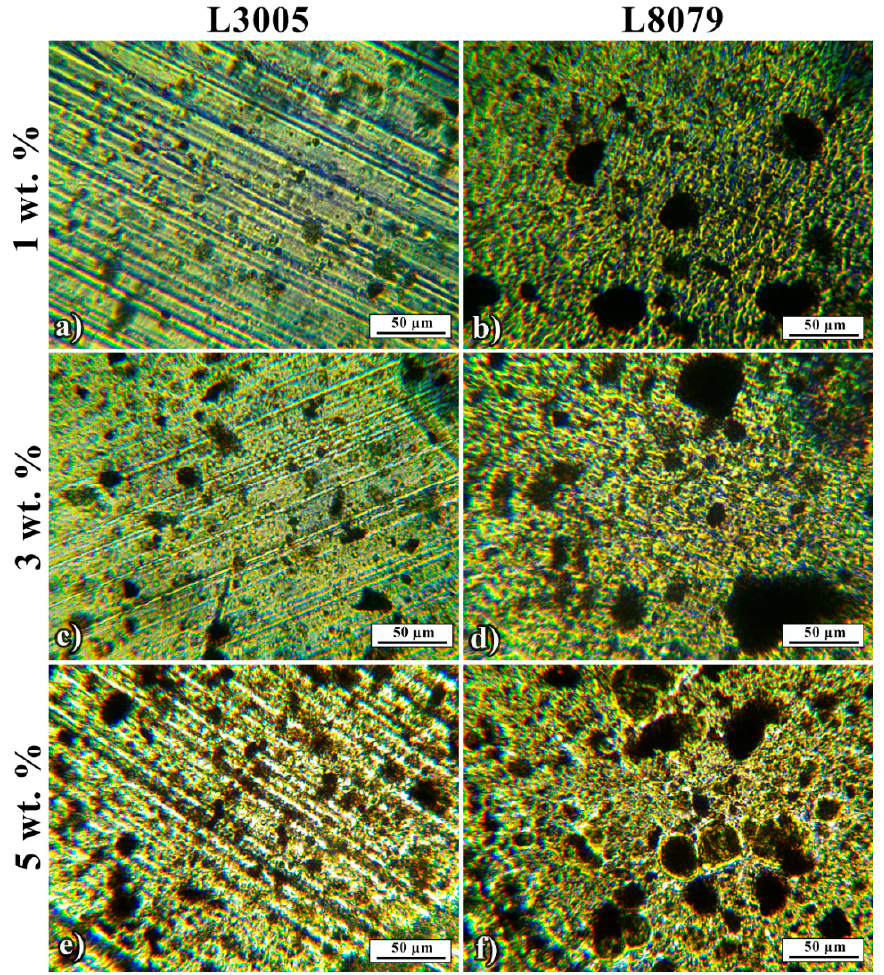
Figure 4. Optical micrographs of composite adhesives: ( a ) 1 wt.% Mn-Al LDH removed from L3005 and ( b ) from L8079 surfaces; ( c ) 3 wt.% Mn-Al LDH removed from L3005, and ( d ) from L8079 surfaces; ( e ) 5 wt.% Mn-Al LDH removed from L3005, and ( f ) from L8079 surfaces.